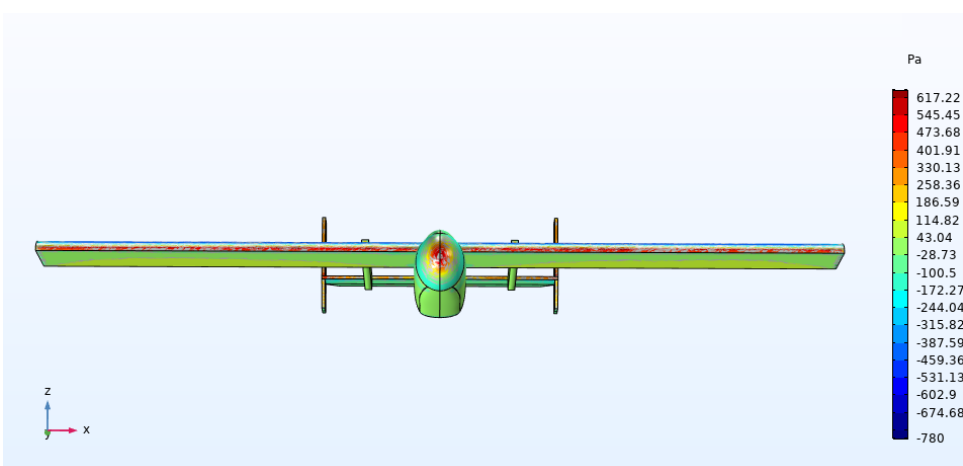
Figure 6. Bottom UAV focused view of maximum pressure in Pa at 2000m of altitude and 3° AOA.